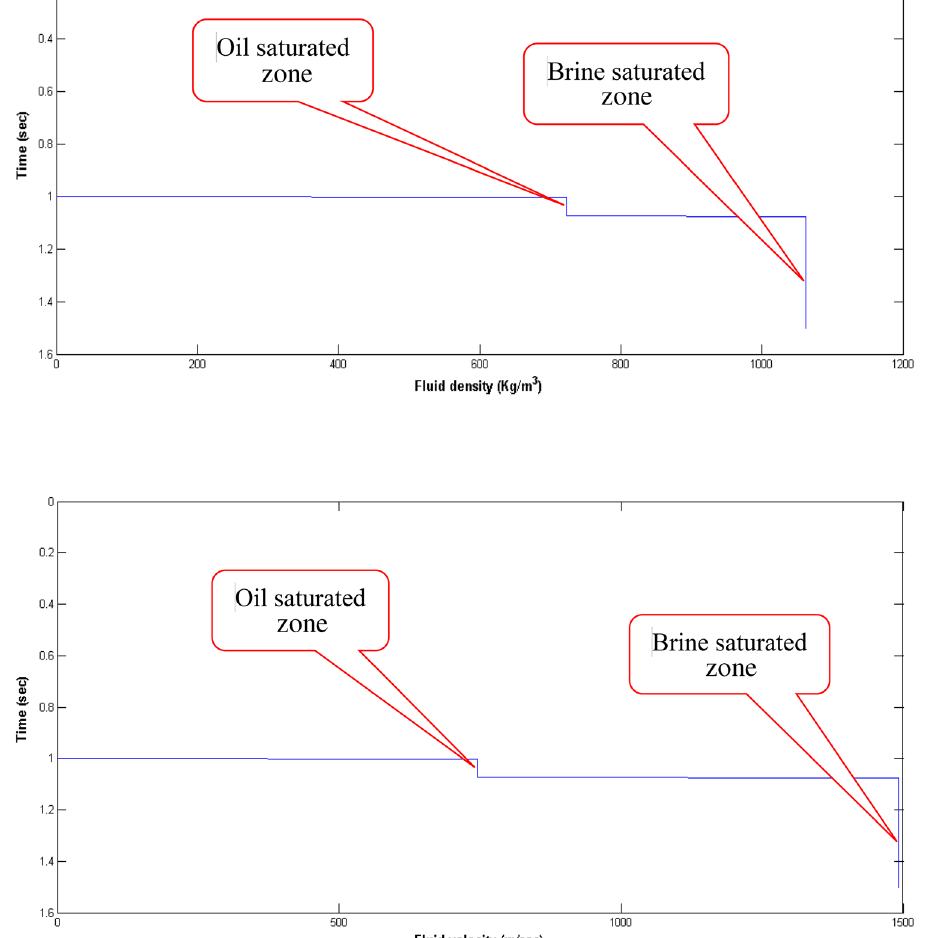
Fig. 13 Fluid density plot with 20% porosity of Arab formation